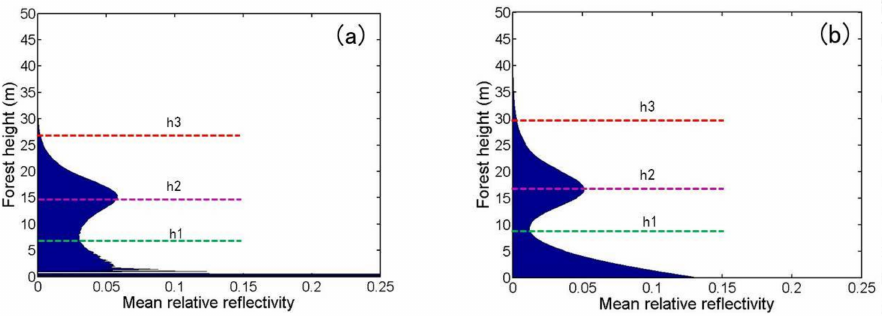
Figure 3. Tomographic profiles of ( a ) stand No. 6 and ( b ) stand No.